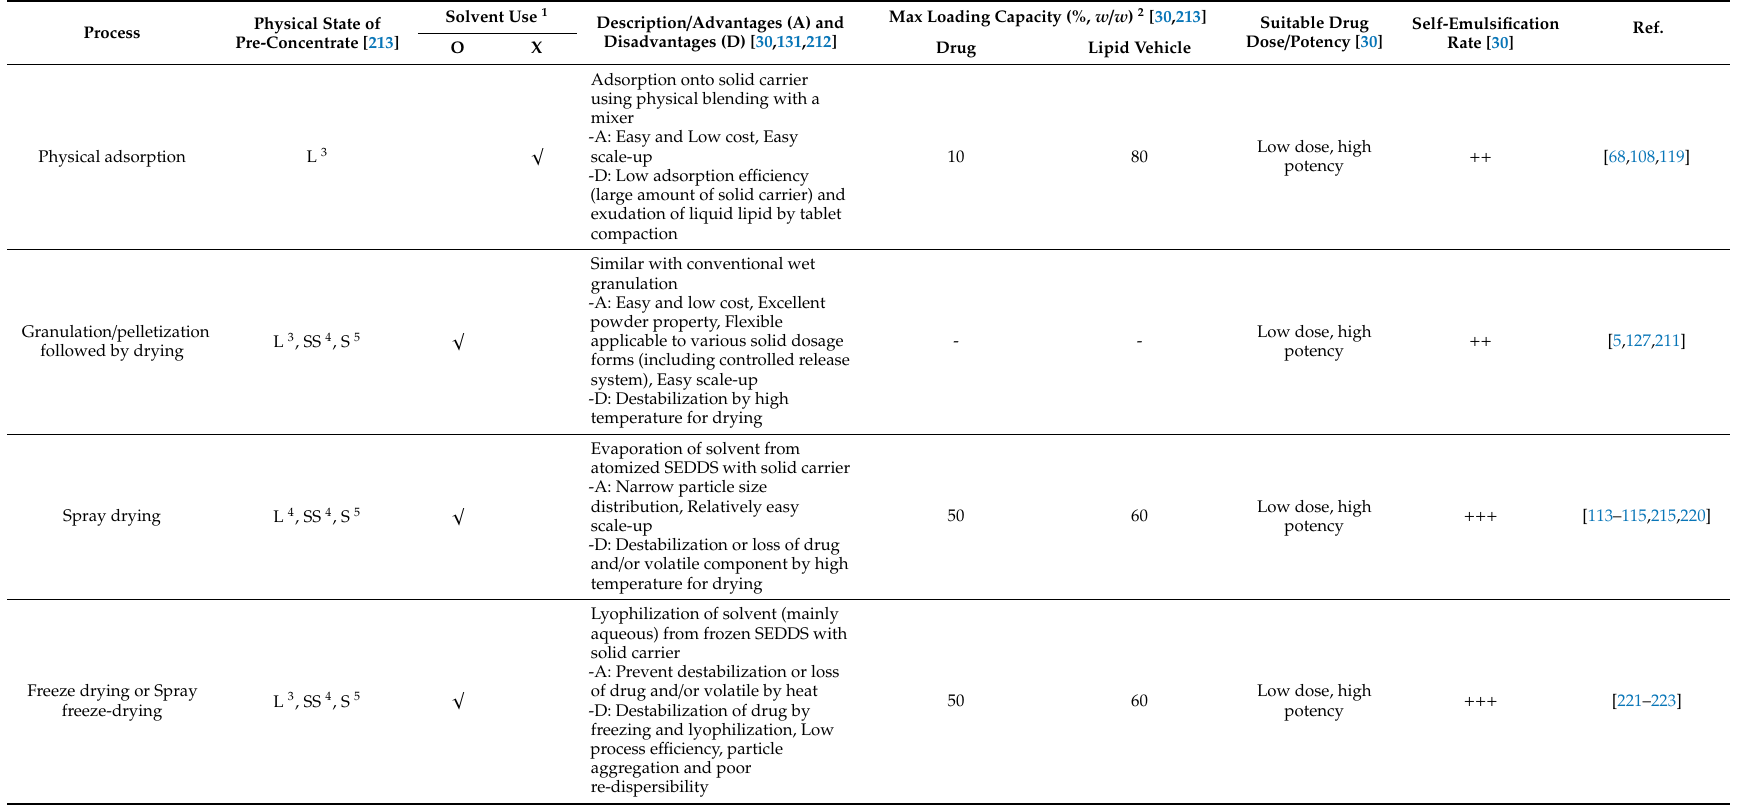
Table 3. Comparison between various solidification process of